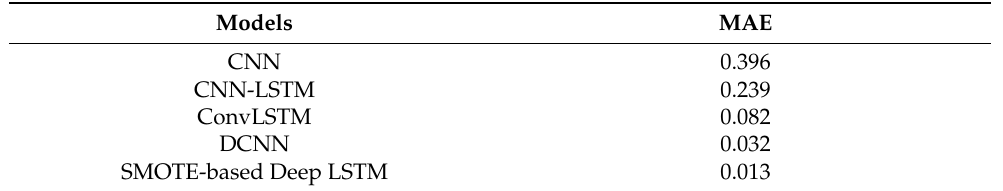
Table 11. MAE of different deep-learning models.